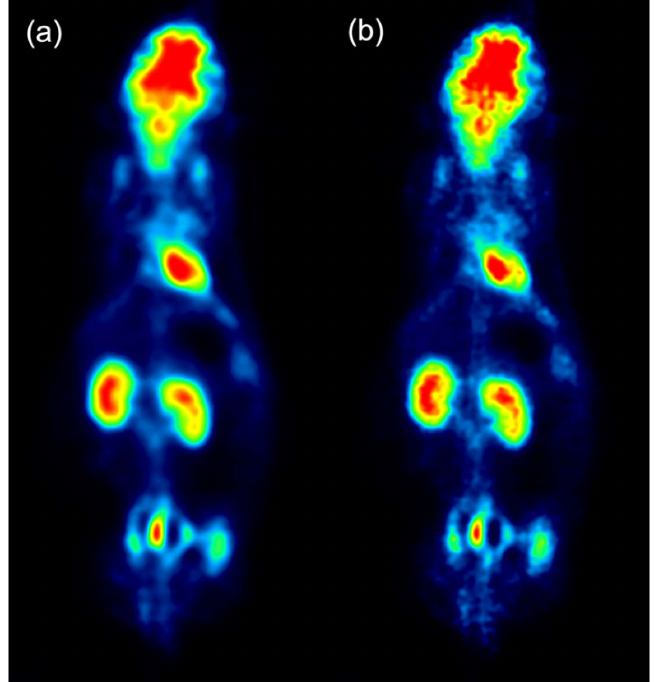
Figure 9. Whole-body PET imaging of a healthy mouse. ( a ) The reconstructed voxel size was 0.472 mm, and the Gaussian post-filter FWHM was 2.36 mm. ( b ) The reconstructed voxel size was 0.314 mm, and the Gaussian post-filter FWHM was 1.57